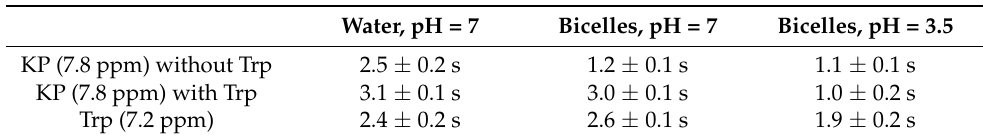
Table 1. Spin-lattice (T 1 ) relaxation times of ketoprofen signals (chemical shift 7.8 ppm) and trypto- phan protons (chemical shift 7.2 ppm) in different